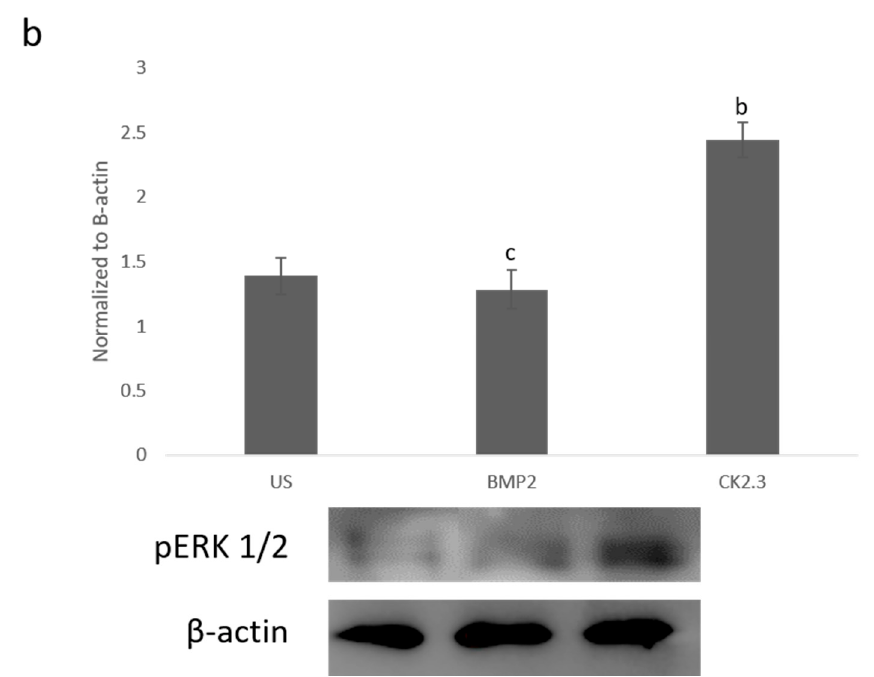
Figure 1. Mature osteoblasts were extracted from osteoporosis (OP) patients and stimulated with BMP2, CK2.3 or were left unstimulated (US) for five days. On the fifth day cells were fixed and fluorescently stained for pERK (green) and the nucleus (blue). ( a ) CK2.3 significantly increased fluorescent intensity when compared to BMP2 and US cells. BMP2 stimulation significantly decreased fluorescent intensity when compared to CK2.3 stimulated cells. ( b ) Lysates were also collected from extracted osteoblasts from OP patients and run on an SDS-Page gel to separate the proteins. The separated proteins were then transferred onto an immunoblot and pERK and β -actin protein levels were detected. Expression was detected through densiometric analysis using ImageJ. CK2.3 significantly increased expression of pERK when compared with US and BMP2 stimulated cells. Error bars represent standard error of the mean (SEM). “a” denotes statistically significant to US, “b” denotes statistically significant to BMP2 stimulated cells, and “c” denotes statistically significant to CK2.3 stimulated cells ( p < 0.05).